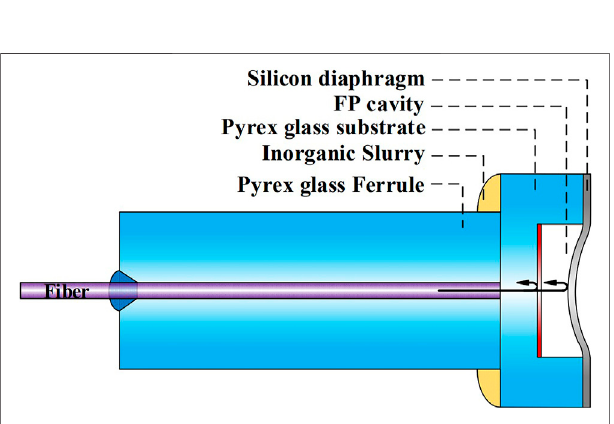
FIGURE 7 | Fiber optic Fabry-Perot high pressure sensor core structure [41].